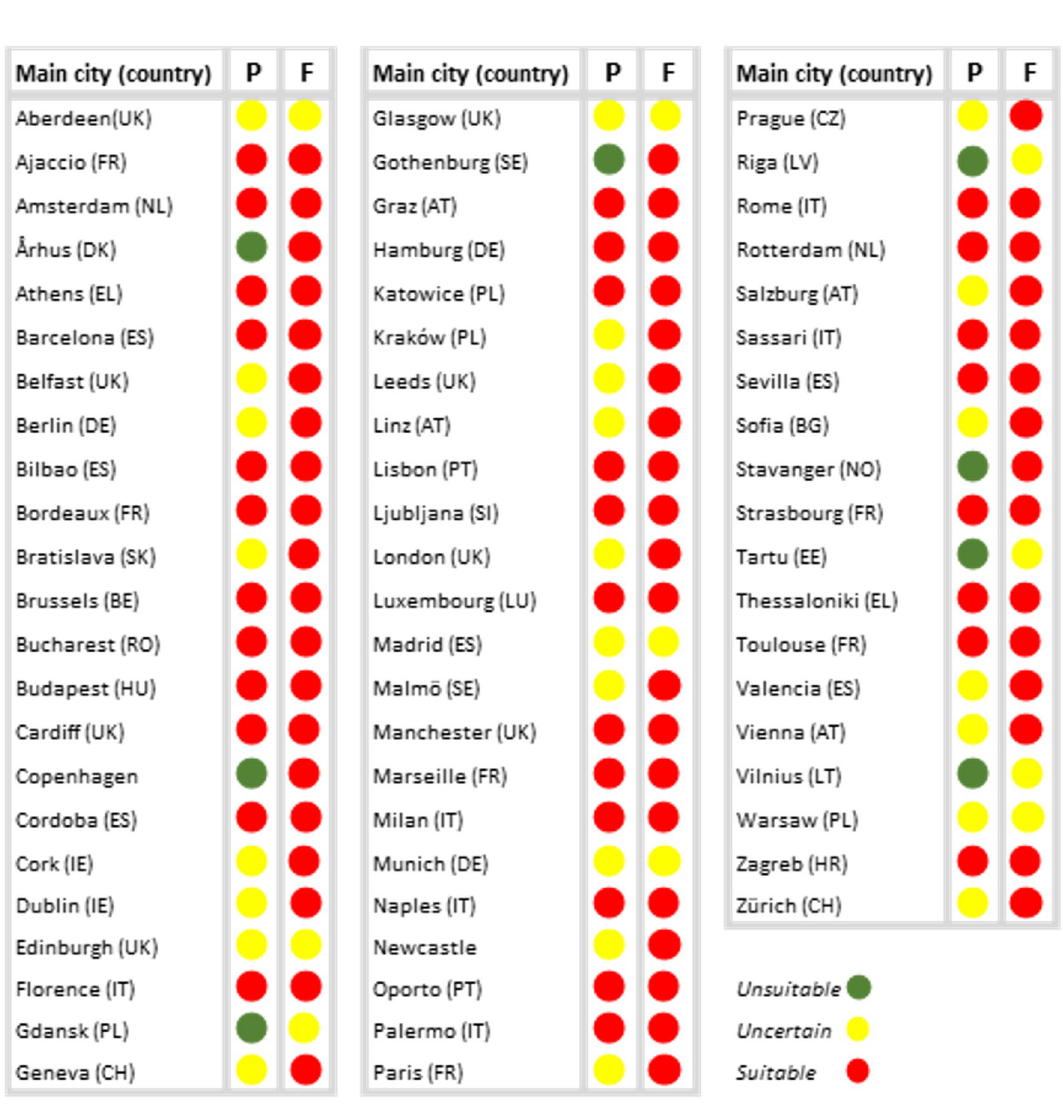
Figure 4. Present and future suitability for Aedes albopictus in functional urban areas of major European cities. P represents present-day conditions; F represents future conditions. Colors follow a traffic-light scheme, with green corresponding to the most favorable situation from the human point-of-view (unsuitable with low uncertainty), red as the most negative situation (suitable with low uncertainty), and yellow as the intermediate situation (high